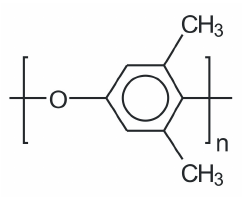
Figure 1. Chemical structure of